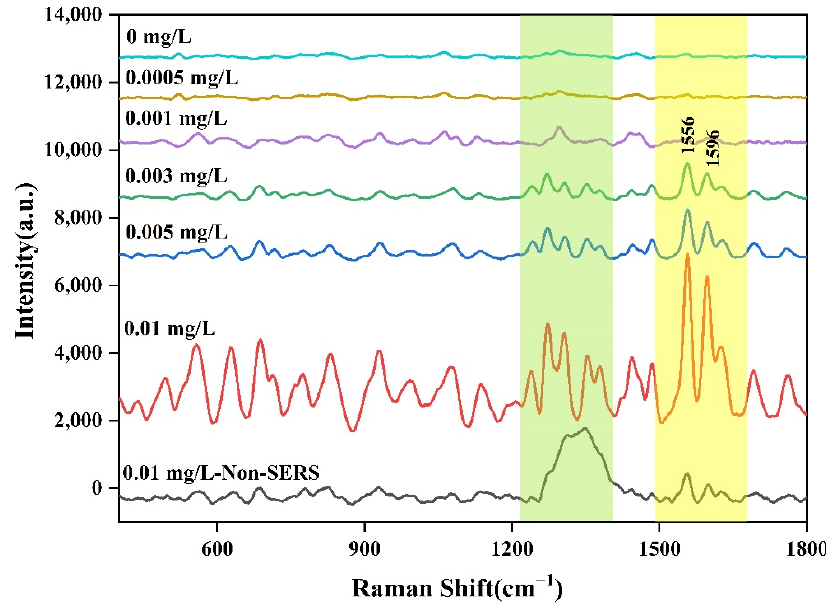
Figure 10. SERS spectra of aflatoxin B 1 with different concentrations.